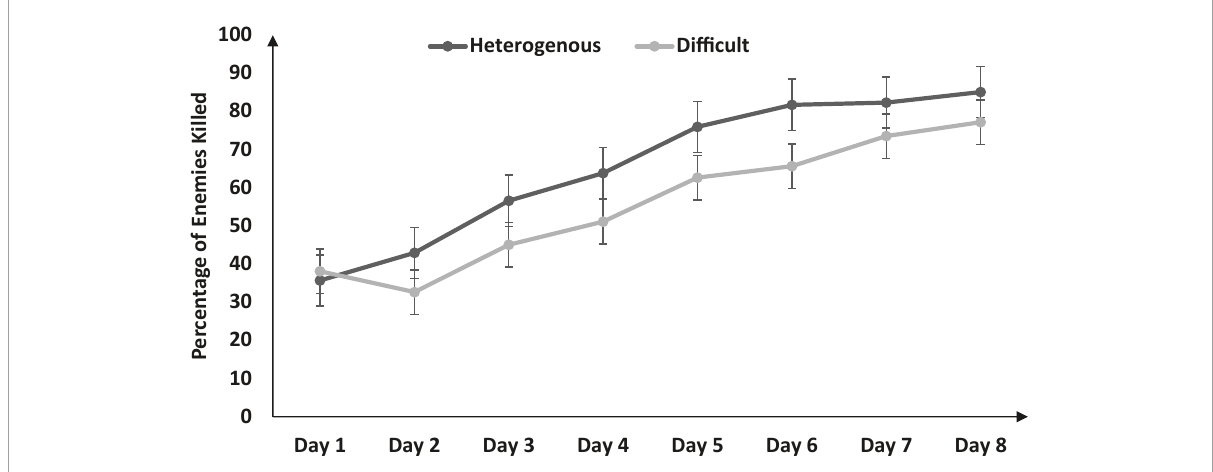
FIGURE3 The percentage of enemies killed across different training conditions and days. The error bars show the 95% CI around point estimates.